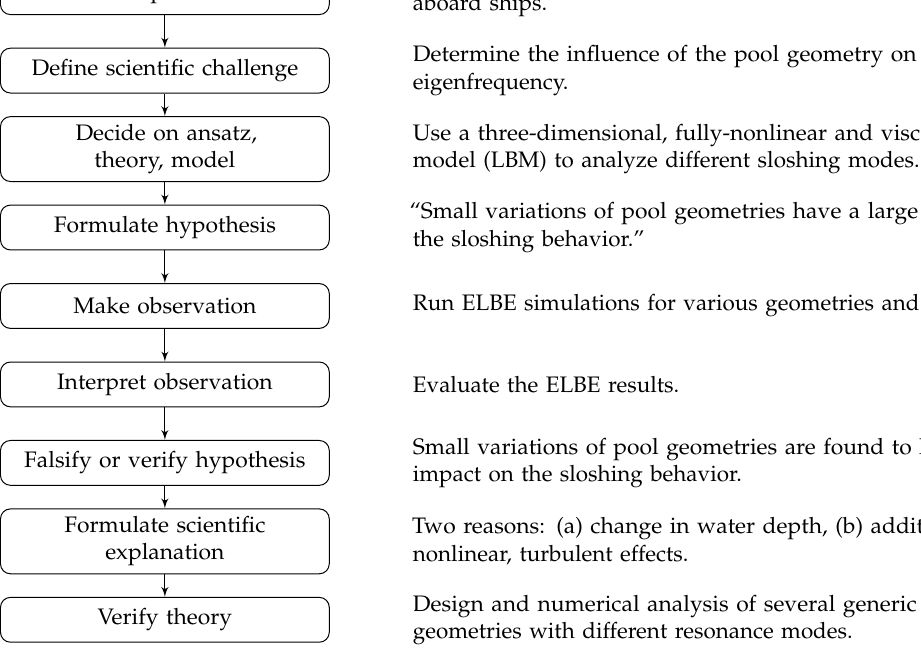
Figure 5. Schematic view of a scientific process. Shown is a linear model; in practice, it often is necessary to repeat one or several steps. On the right, an example is given, based on a master thesis project with ELBE that is aiming at analyzing violent pool sloshing aboard cruise